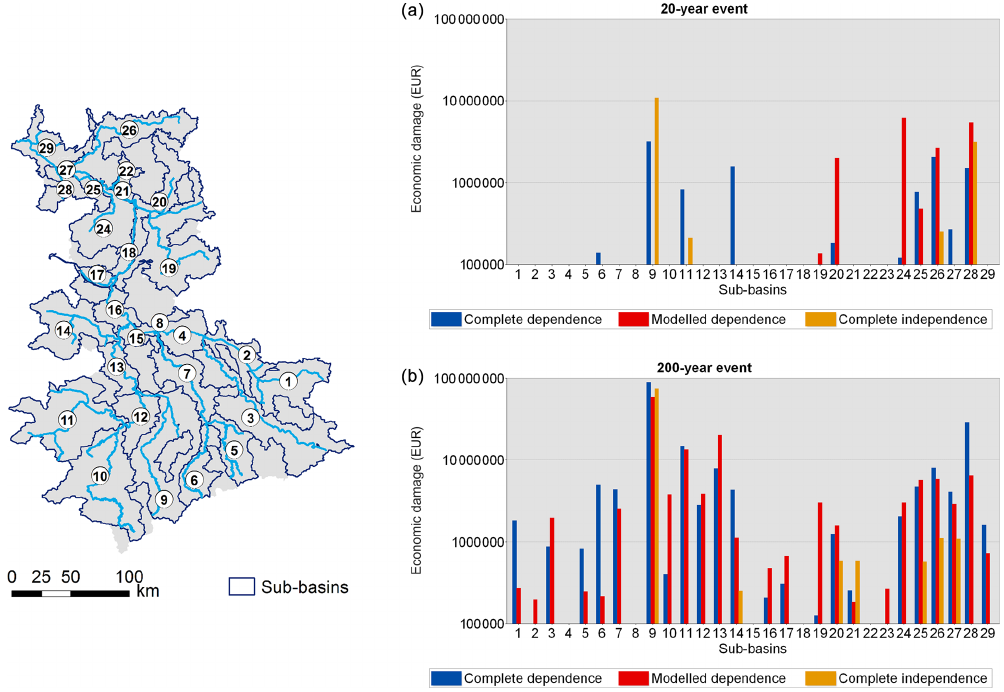
Figure 5. Distribution of damages at the sub-basin level for (a) the 20-year event and (b) 200-year event for three dependence